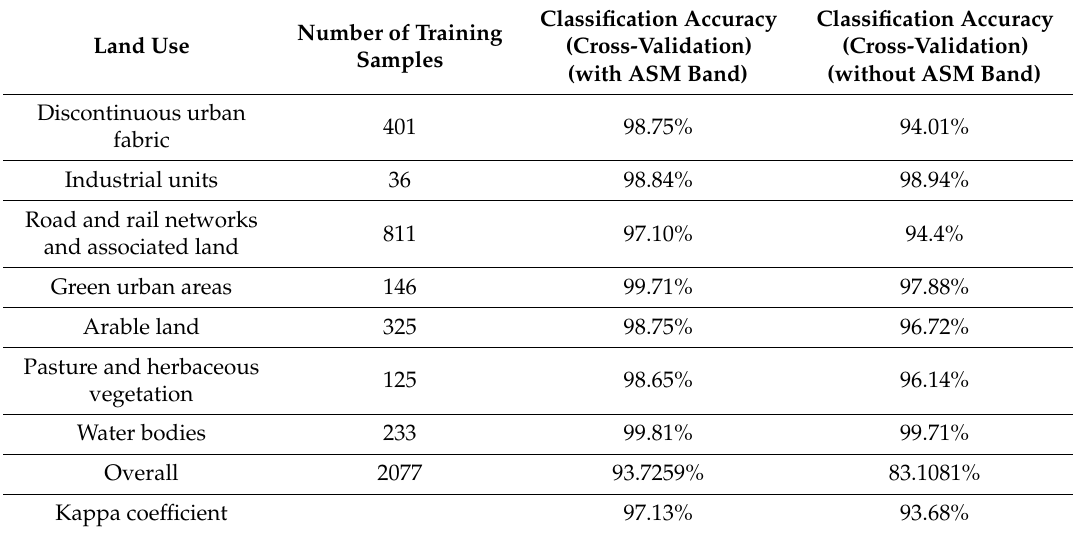
Table 4. Classification accuracy of the random forest method. ASM—angular second moment.